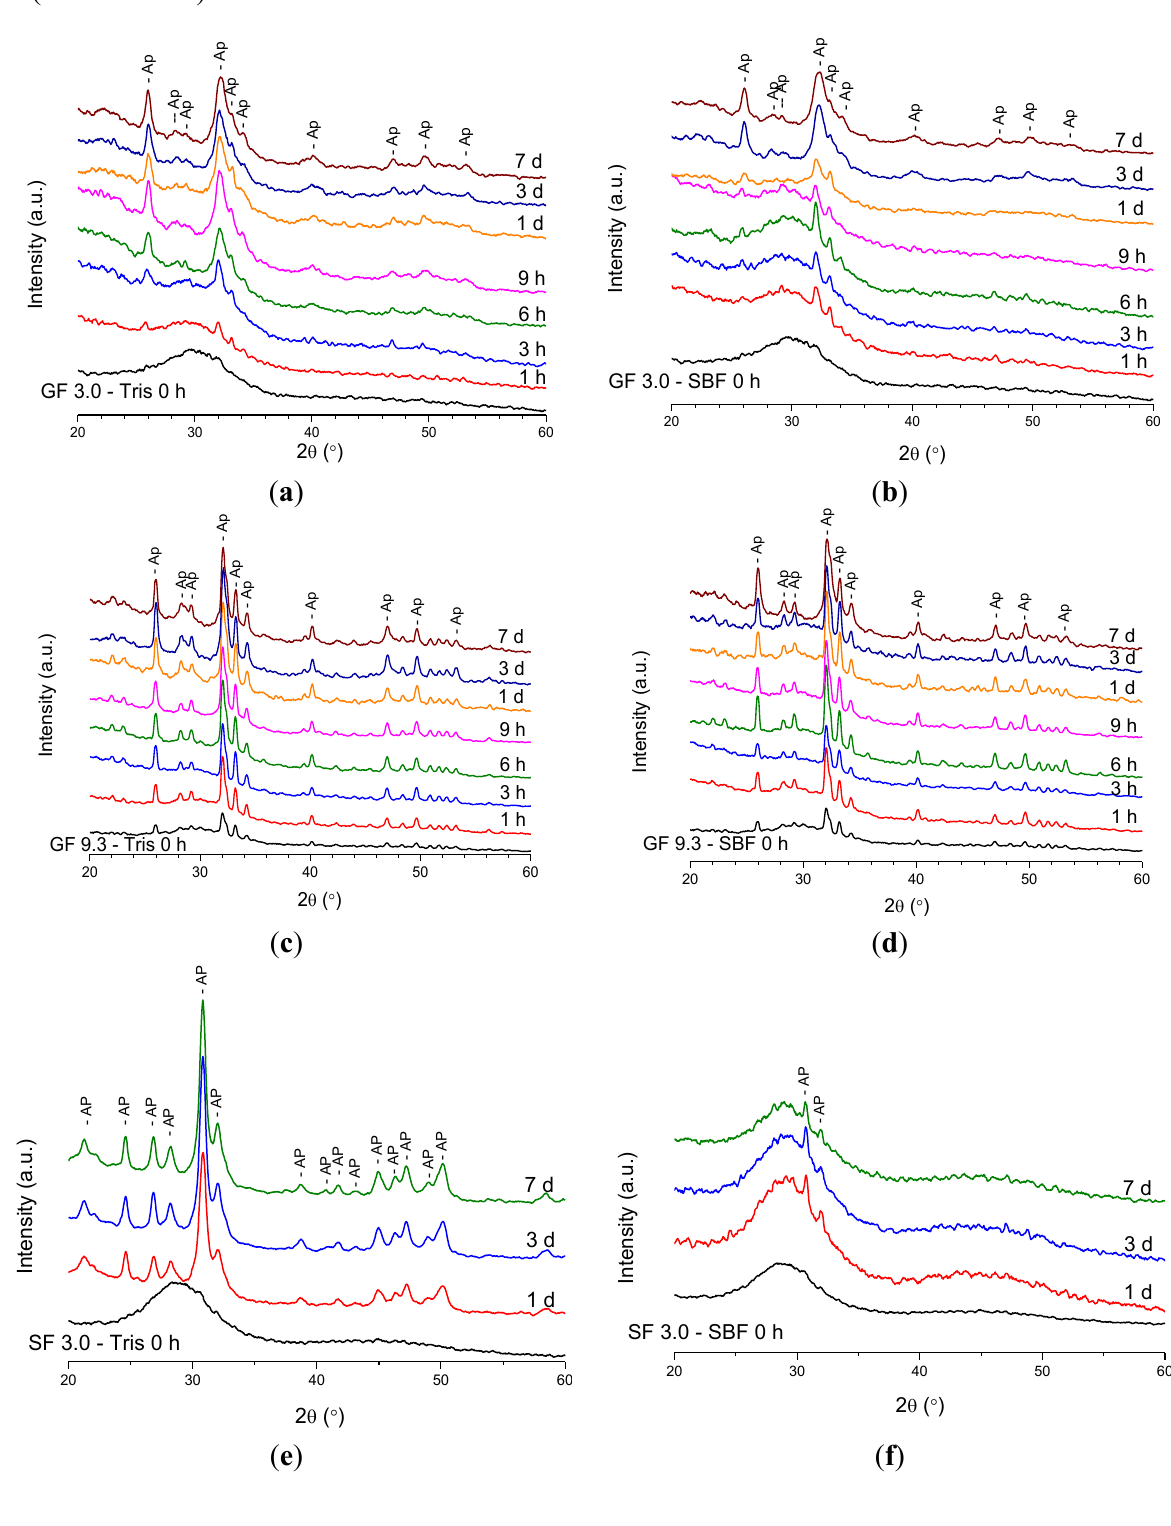
Figure 1. XRD patterns of glasses after immersion in buffer solutions: ( a ) GF 3.0 in Tris; ( b ) GF 3.0 in SBF; ( c ) GF 9.3 in Tris; ( d ) GF 9.3 in SBF; ( e ) SF 3.0 in Tris; ( f ) SF 3.0 in SBF; ( g ) SF 9.3 in Tris; ( h ) SF 9.3 in SBF. Label Ap in CaF Ca (PO ) F (00-034-0011), and strontium fluorapatite Sr 5 4 3